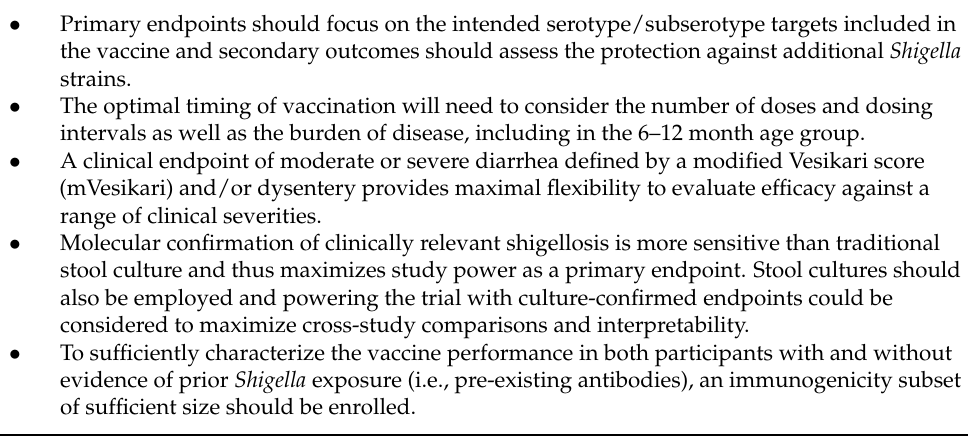
Table 1. Key considerations for the design of pivotal Shigella vaccine efficacy